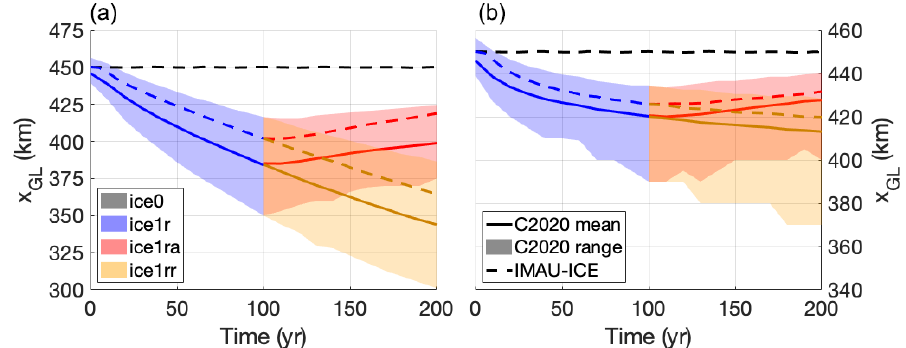
Figure 8. Grounding-line position over time in the different MISMIP + experiments: (a) experiments ice0 (black), ice1r (blue), ice1ra (red), and ice1rr (gold) and (b) experiments ice0 (black), ice2r (blue), ice2ra (red), and ice2rr (gold). The range and mean of the model ensemble by Cornford et al. (2020) are shown by shaded areas and solid lines (labelled C2020 range and C2020 mean), respectively. The results of the IMAU-ICE simulations are shown by dashed lines. Note the different y -axis scales of the two